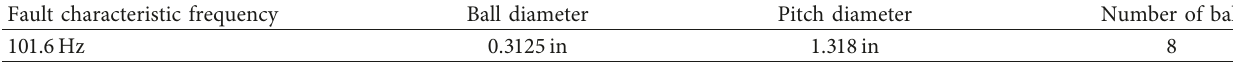
Table 5: Sampling conditions.